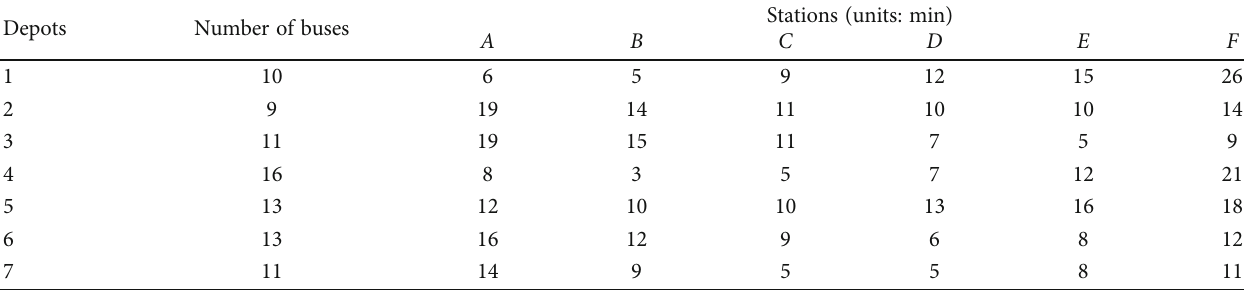
Table 6: The depot capacity and travel time to URT stations.